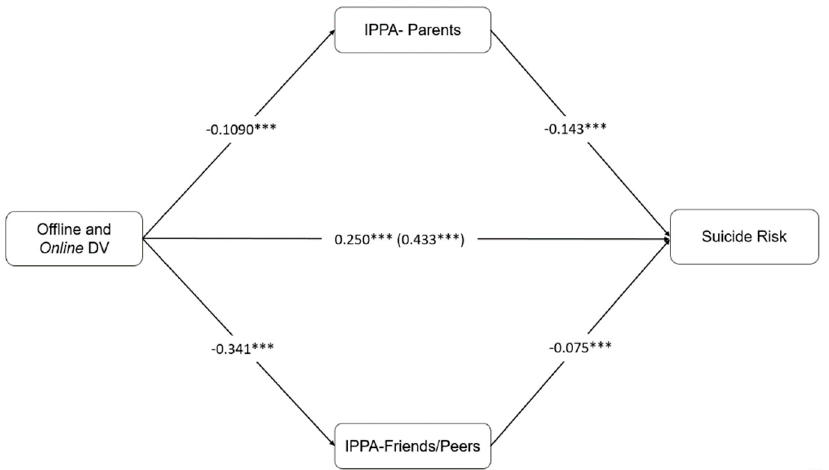
Figure 3. Model 3 with IPPA–P and IPPA–F as a Mediation in the Effect of off-online DV on Suicide